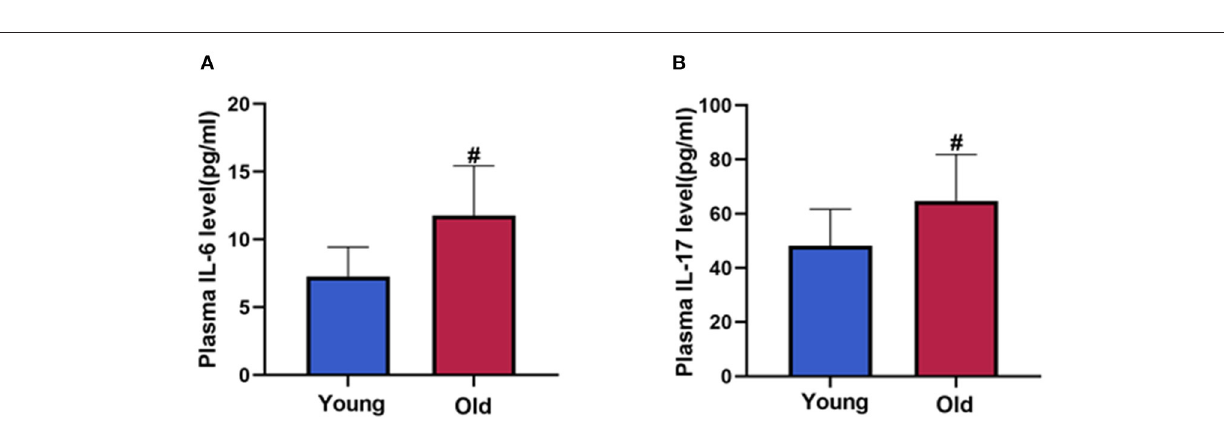
EFC function may be used as an indicator to assess the severity and prognosis of NSTEMI, and increment of circulating EPC function may be beneficial to the prognosis of